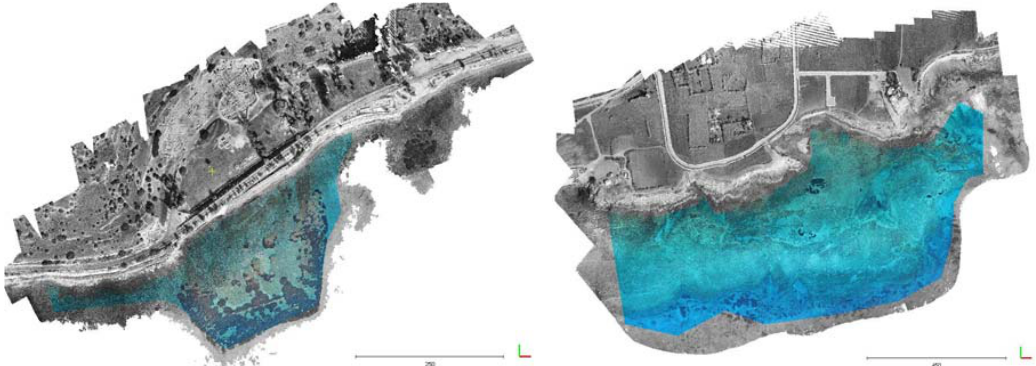
Figure 14. Amathounta test site ( left ) and Agia Napa test site ( right ). The selected areas for applying the tests are illustrated with red ‐ green ‐ blue (RGB) colours while the rest area in greyscale.